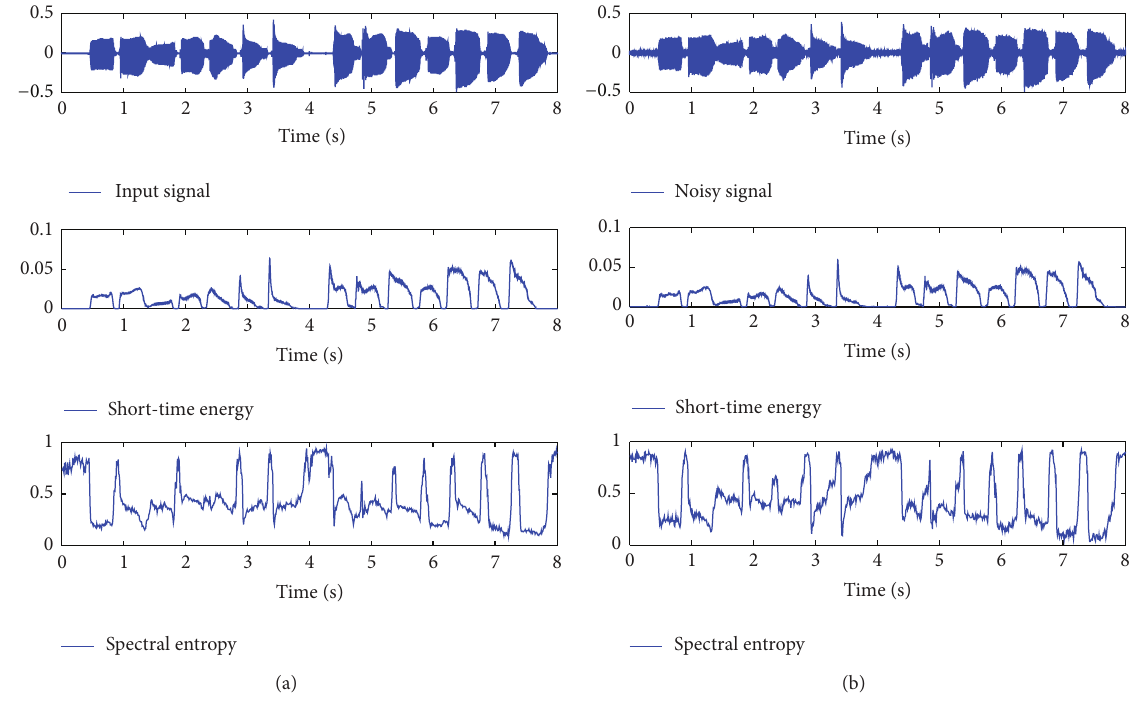
Figure 4: Clean/noisy signal and its correspondence short-term energy and spectral entropy.